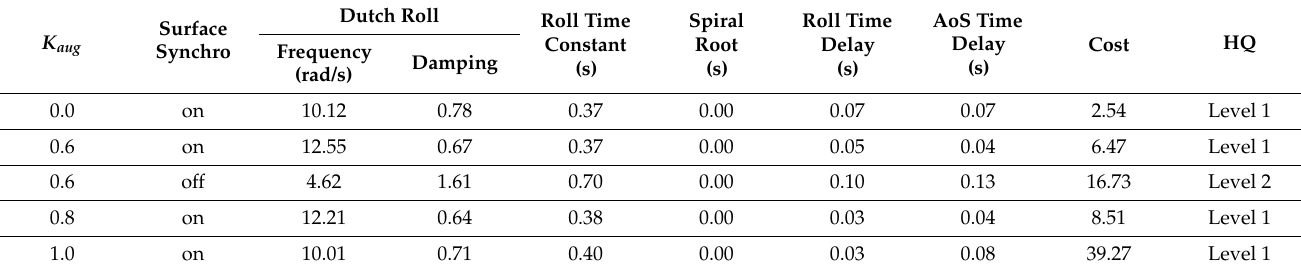
Table 2. Result of equivalent system analysis as a variation of additional augmentation gain and control surface synchro- nization in Mach 0.8, altitude 20 K, 1 g level flight.